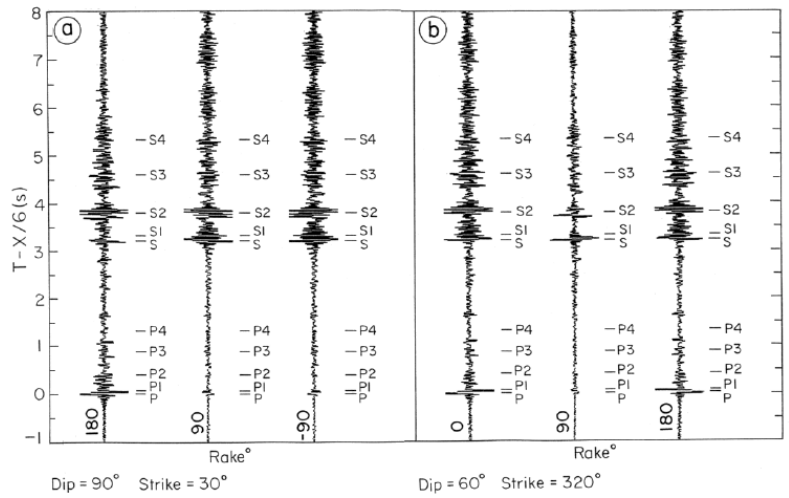
Figure 4. (a) Same as Figure 3a for the right-lateral strike-slip (rake 180°) and the dip-slip (rake ±90°) mechanism. Note very low amplitude P phases and relatively high amplitude S phases for the rake angles ±90°. (b) Same as Figure 3a for the reverse (thrust) mechanism. Note very low amplitude P phases for the intermediate rake angle